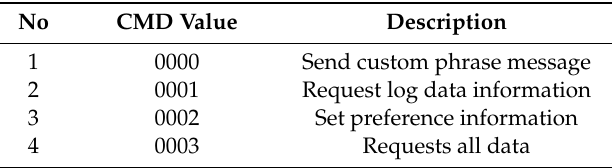
Table 3. Description of Command